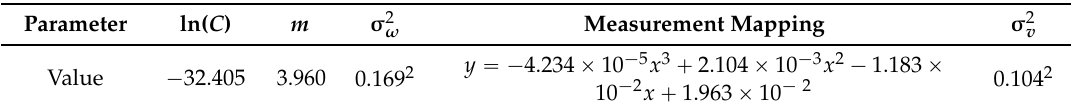
Table 6. The state space model parameters of the specimens T 3